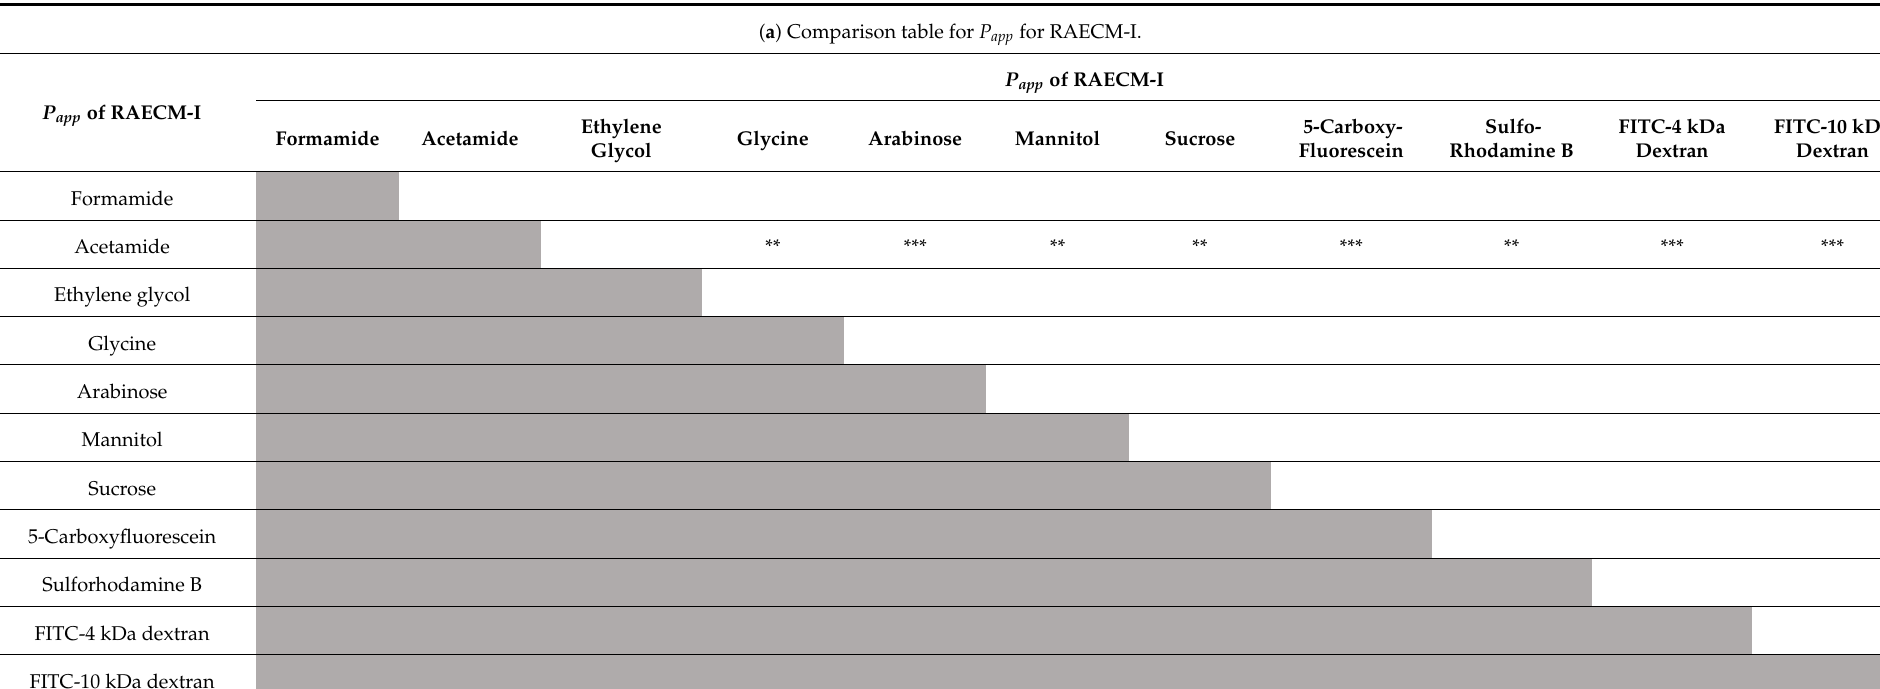
( a ) Comparison table for P app for